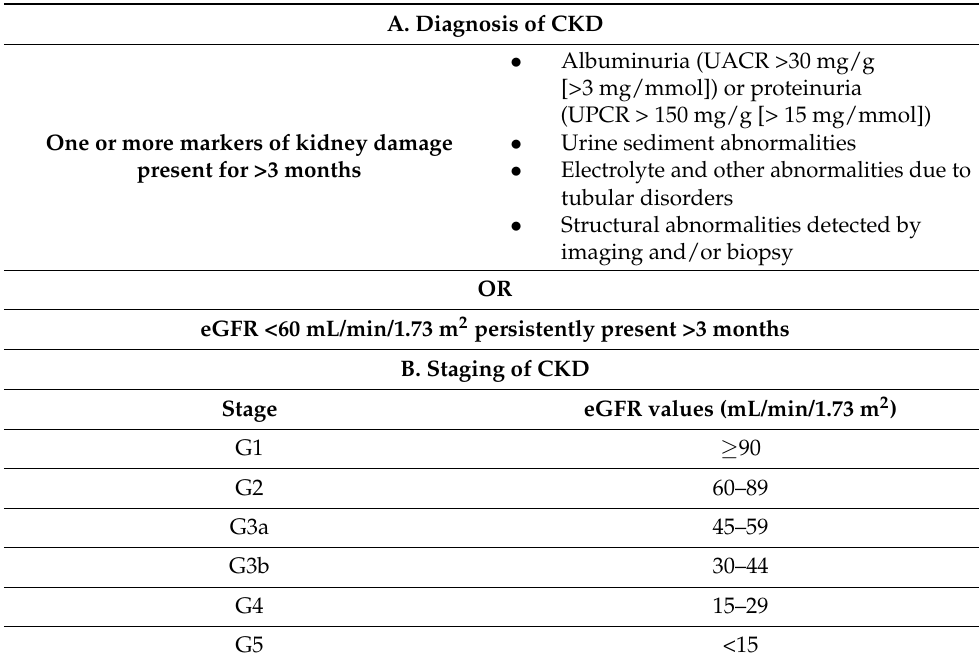
Table 2. Criteria for diagnosis ( A ) and staging ( B ) of CKD.